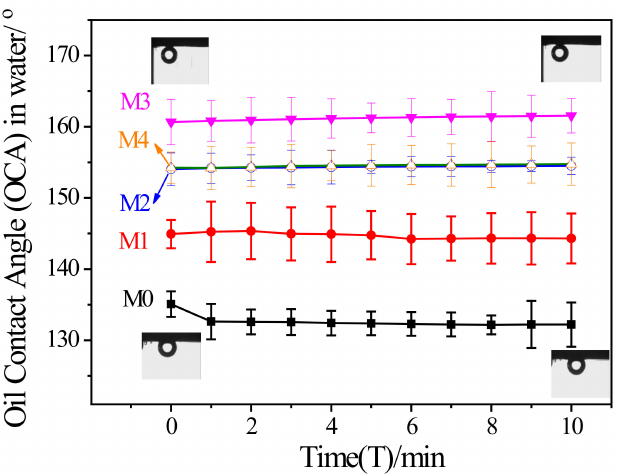
Figure 4. Measured OCA for the various PVDF-based membranes